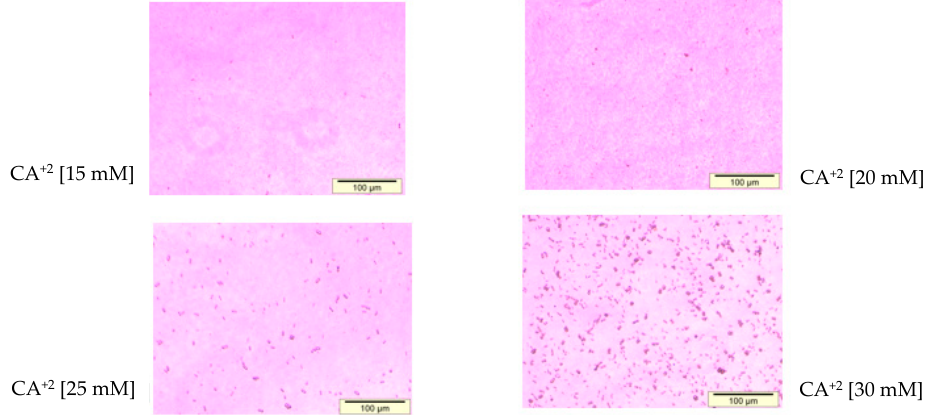
Figure 3. Optical microscopic size estimation of NPs developed by mixing 15–30 mM of exogenous CaCl 2 (3–6 μ L from 1 M stock), followed by incubation of the mixture for 30 min at 37 °C, as described in detail in Section 2.3. The aggregation of the particles was visualized by the observation of large-sized crystals under an optical microscope. All images were captured at 10 ×